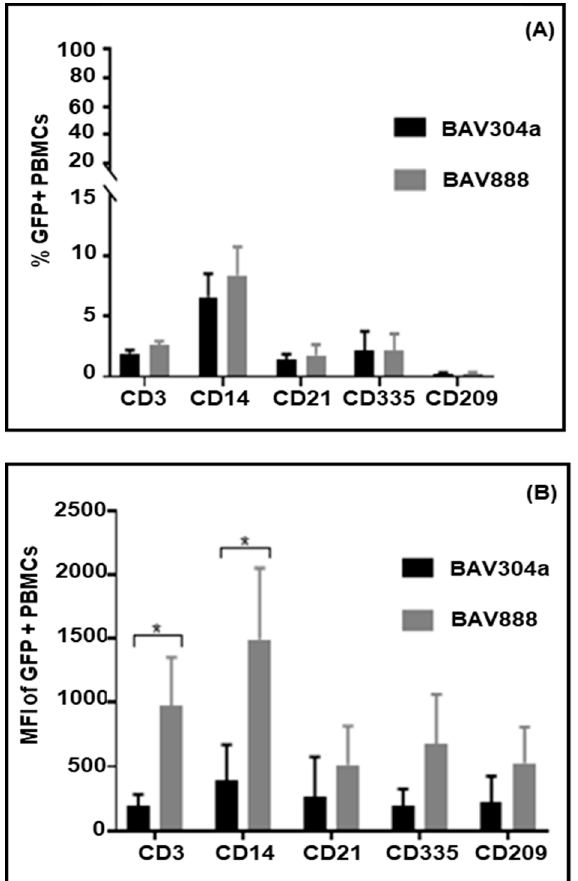
Figure 6. Comparison of bovine leukocyte transduction by BAV304a or BAV888. Bovine PBMCs were transduced for 16 h with either BAV304a or BAV888 (MOI = 1). Cells were labelled with lineage-specific monoclonal antibodies and analyzed for co-expression of GFP: T cells (CD3 + ), monocytes (CD14 + ), B cells (CD121 + ), innate lymphoid cells (CD335 + ), and DCs (CD209 + ). The percent GFP + cells (panel A ) and EYFP mean fluorescence intensity (MFI) (panel B ) were analyzed for each PBMC lineage. Data presented are the mean + 1SD of values from PBMCs isolated from five animals. * Significant ( p < 0.05) differences when comparing BAV304a or BAV888 transduction within a leukocyte lineage.